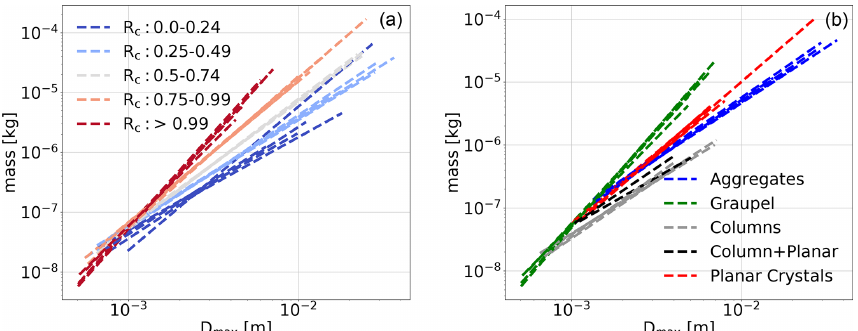
Figure 6. m(D max ) power law relations for the data of various field campaigns, as listed in Tables 4 and 5. (a) Data are color-coded according to riming index R c by Praz et al. (2017). (b) Data are color-coded according to the hydrometeor classes, also by Praz et al. (2017). Different curves of the same color correspond to different field campaigns.